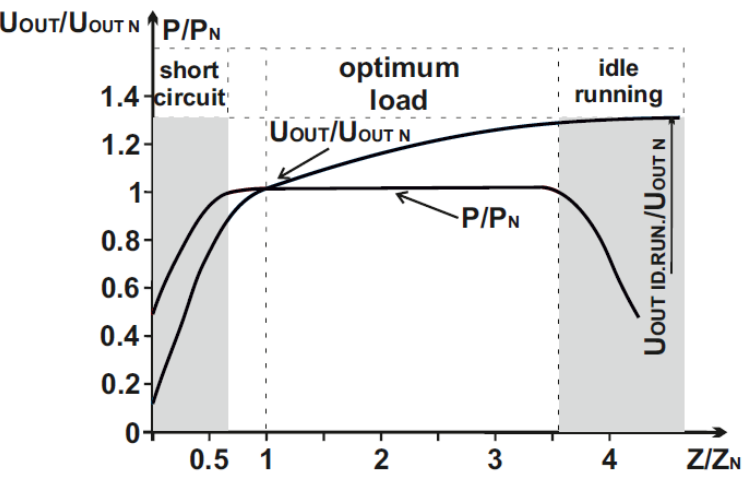
Figure 6. Dependence of the output voltage and power on the variation of the load.